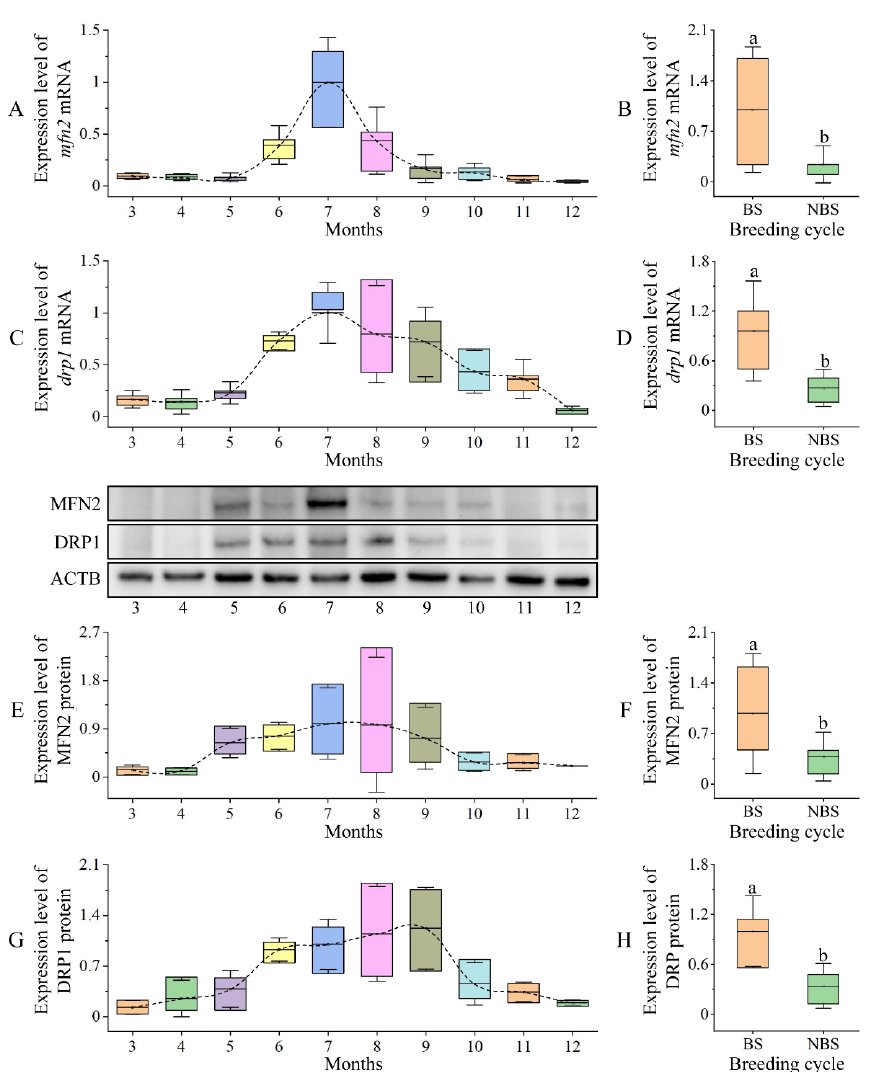
Figure 4. Expression of mfn2 and drp1 mRNA and protein in the coelomic fluid of male P. esculenta during different months and breeding cycle stages. ( A , C , E , G ) Expression of mfn2 and drp1 mRNA and protein in coelomic fluid during different months. Expression first increased and then decreased. ( B , D , F , H ) Expression of mfn2 and drp1 mRNA and protein in coelomic fluid during different breeding cycle stages. The different letters above columns indicate significant differences ( p < 0.05). BS: breeding stage, NBS: non-breeding stage.